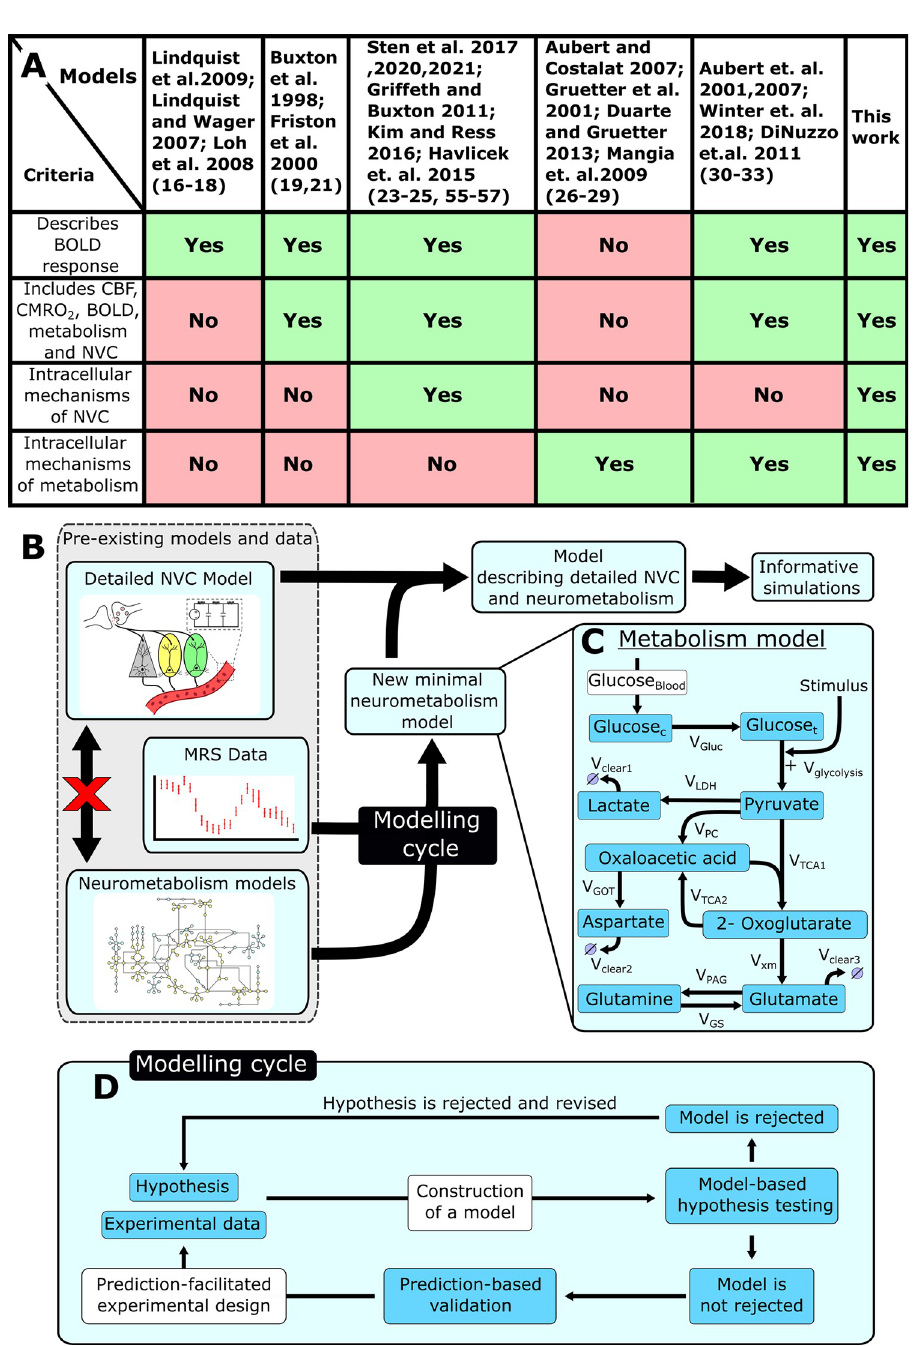
Fig 1. Overview of the modelling work presented herein. A. A table summary of different models and what aspects of the neurovascular coupling they cover [16–19,21,23–33,55–57]. B. A schematic overview of how this work connects pre-existing models for the NVC with a description for the cerebral metabolism and how this new interconnected model can be used for informative simulations. C: A detailed illustration of the metabolism model precented in this work. Neuronal activity triggers increased consumption of glucose, which triggers downstream signaling cascades of different metabolites, which can be captured using MRS. D. A schematic illustration of the modelling cycle used to develop a minimal